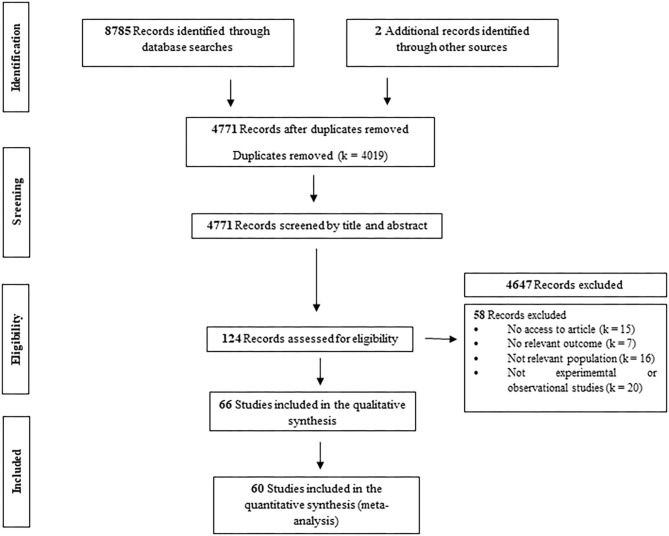
Flow chart of the methodology for the search results.